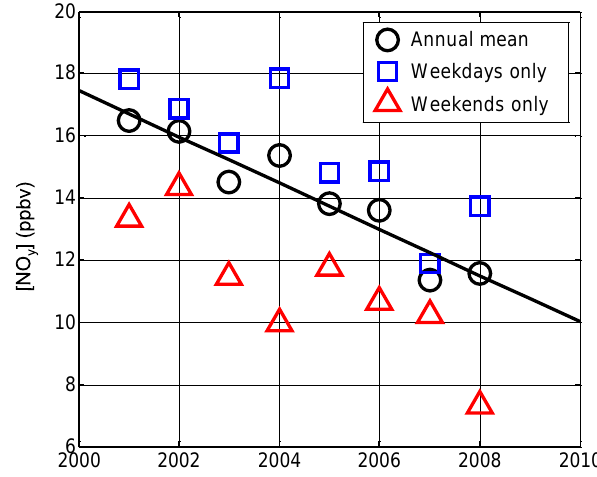
Fig. 2. Annual mean [NO y ] in the Sacramento metro region from 2001–2008. Values calculated from daily (10–1400PST) means of 4 sites (T Street, Del Paso, Roseville, and Folsom) in each year of the study